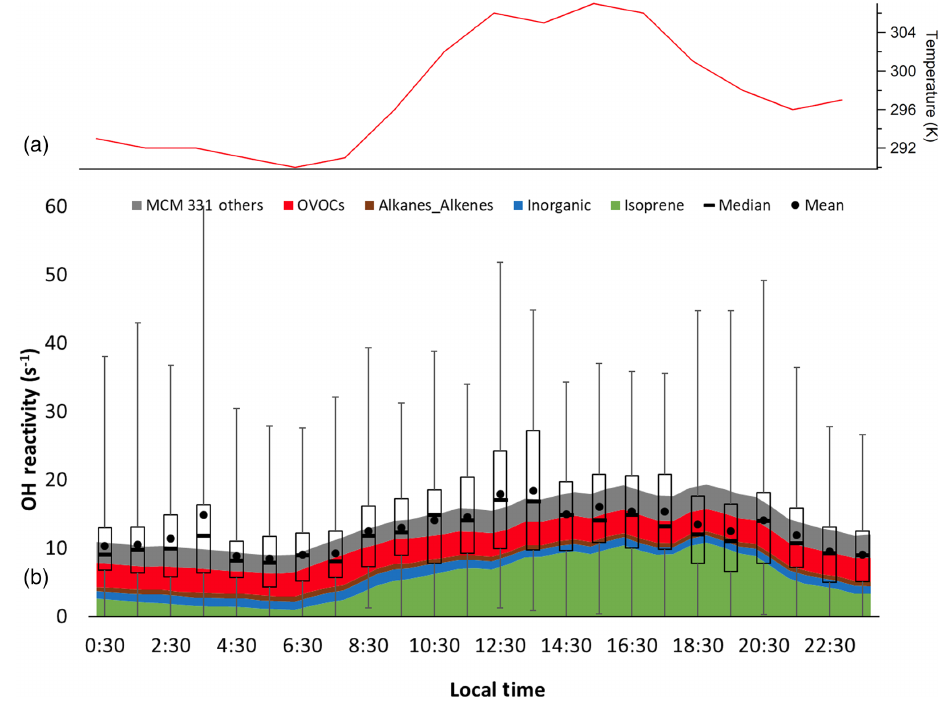
Figure 8. Diurnal temperature (a) and box and whiskers plot of observed total OH reactivity measured during the entire campaign showing the mean and median values for each hour with the mean-calculated values from the measured OH sinks, as well as the unmeasured oxidation products from the MCM 3.3.1 model results (b) . Error bars show the range of individual 5min measurements, and bars show Q1 and Q3 for the measured OH